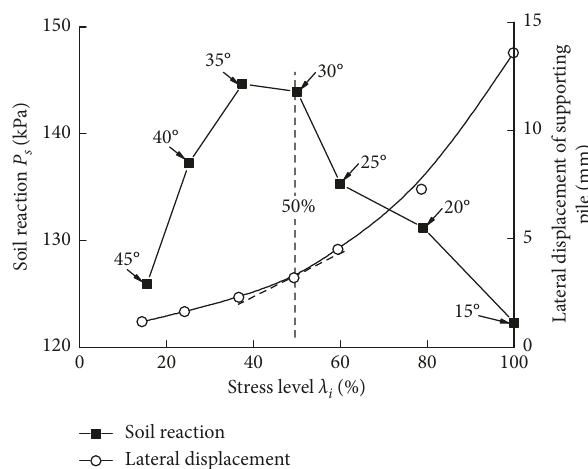
Figure 6: Curve of the relationship between the soil reaction and lateral displacement of the supporting pile at (1/3) h d and the stress level λ i .